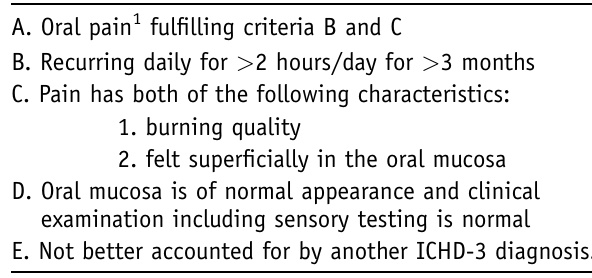
Table I. Diagnostic criteria of the ICHD-3 (2018) for BMS.